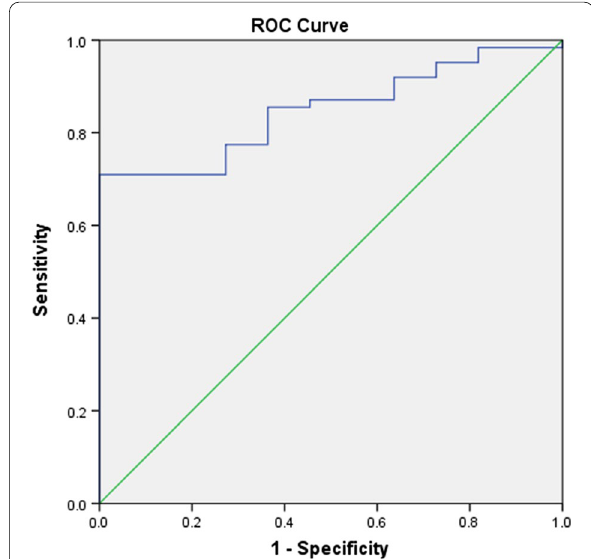
Fig. 3 Roc curve for air locules volume with cutoff value of and AUC was 0.83 and P ‑value